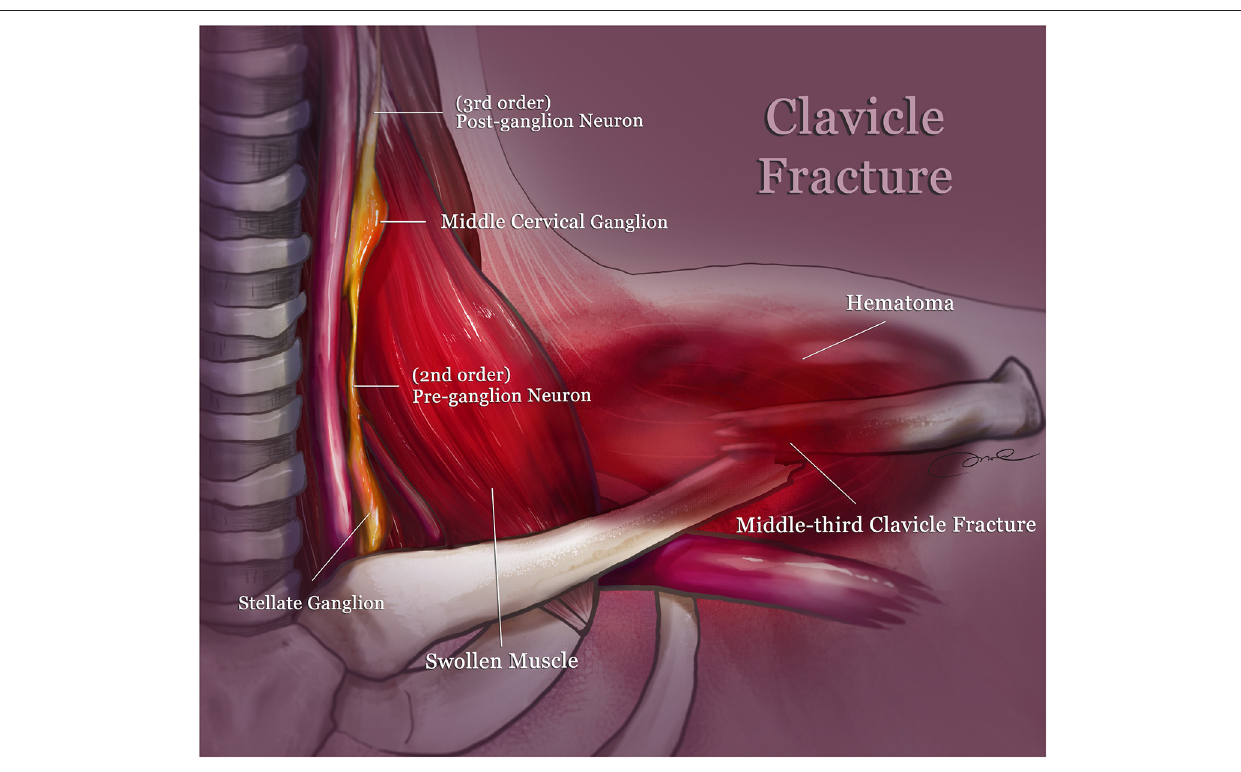
Frontiers in Surgery |